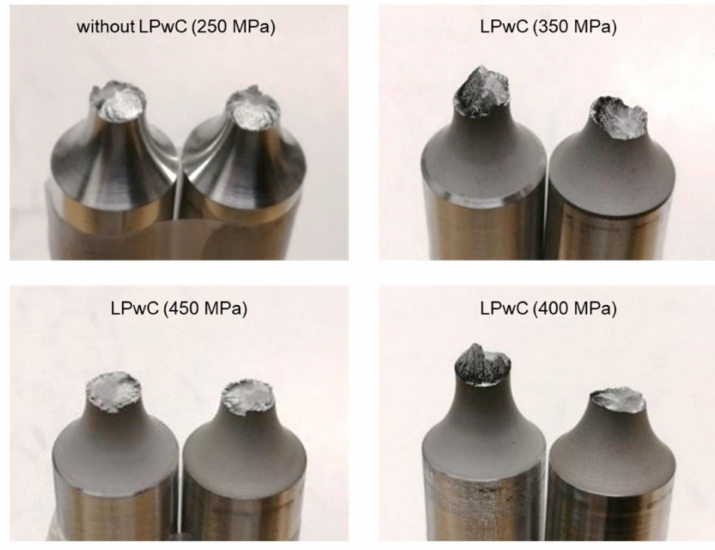
Figure 8. Fracture surfaces of A7075BE-T6511 samples with and without